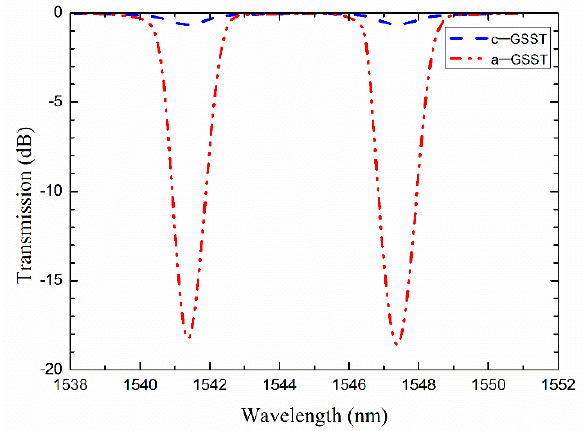
Figure 9. Spectral response of proposed MRR switch when GSST is in amorphous and crystalline states.